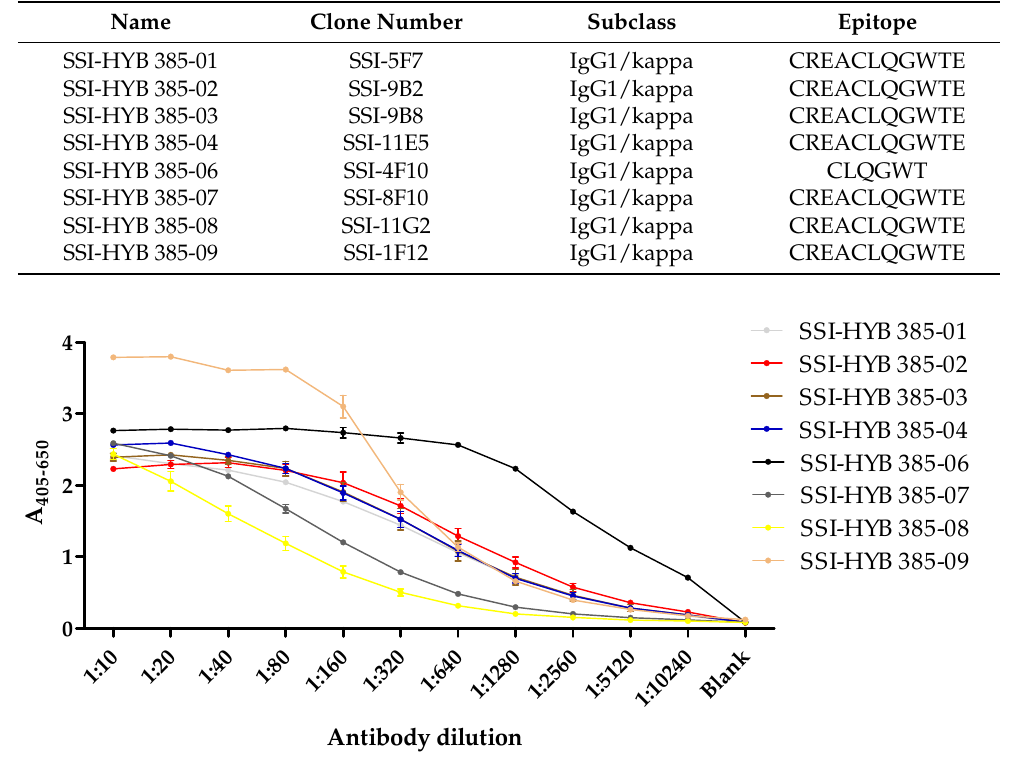
Figure 3. Titration of SSI-HYBs analysed by enzyme-linked immunosorbent assay. A two-fold dilu- tion series ranging from 1:10–1:10240 was